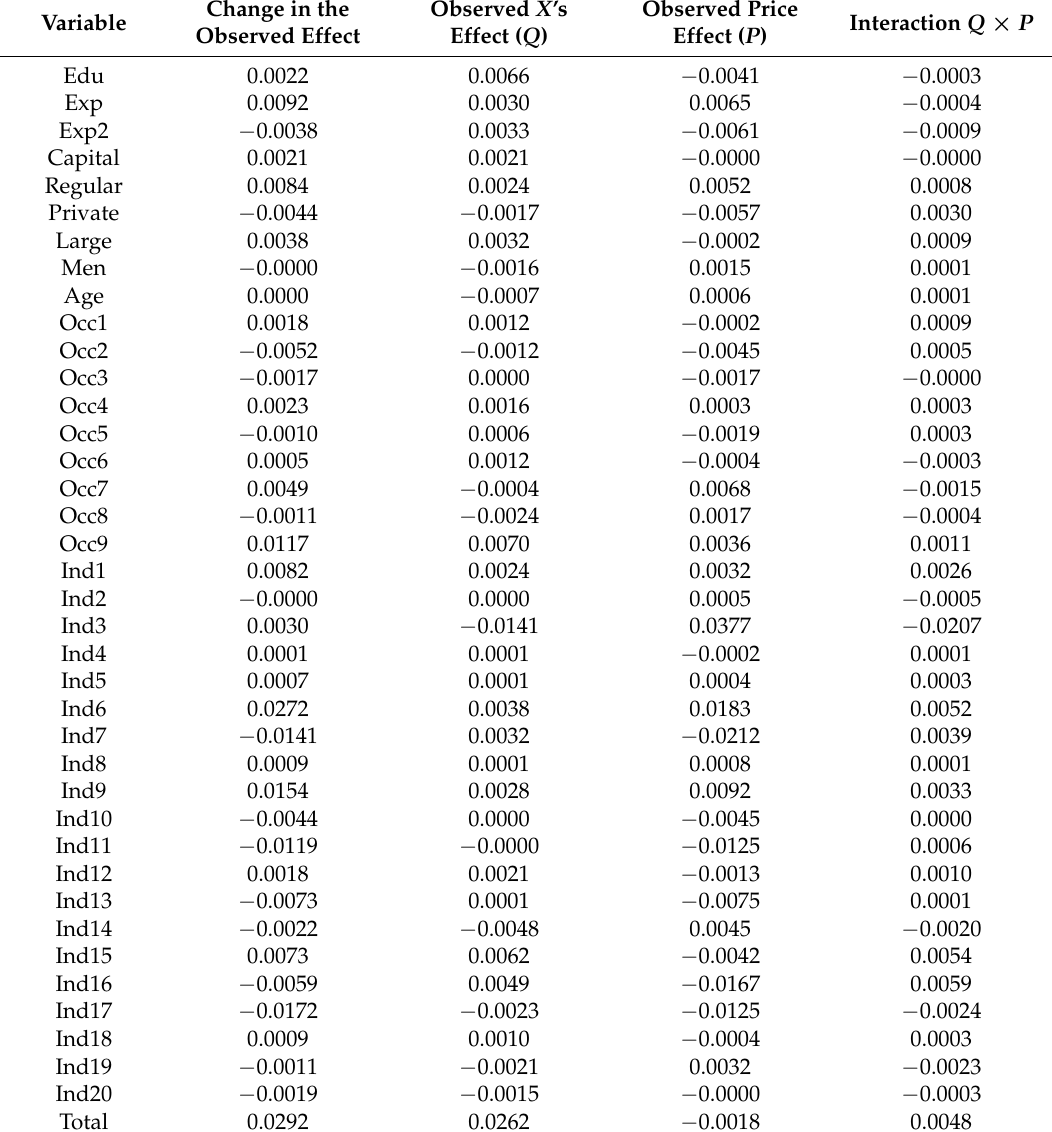
Table 8. Juhn-Murphy-Pierce decomposition of changes in wage